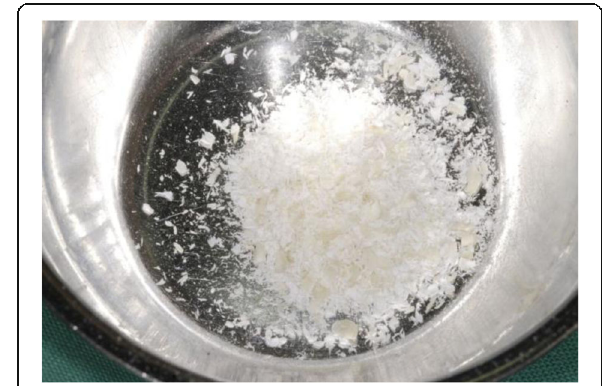
Fig. 8 Autologous, particulated dentin in the alveolar